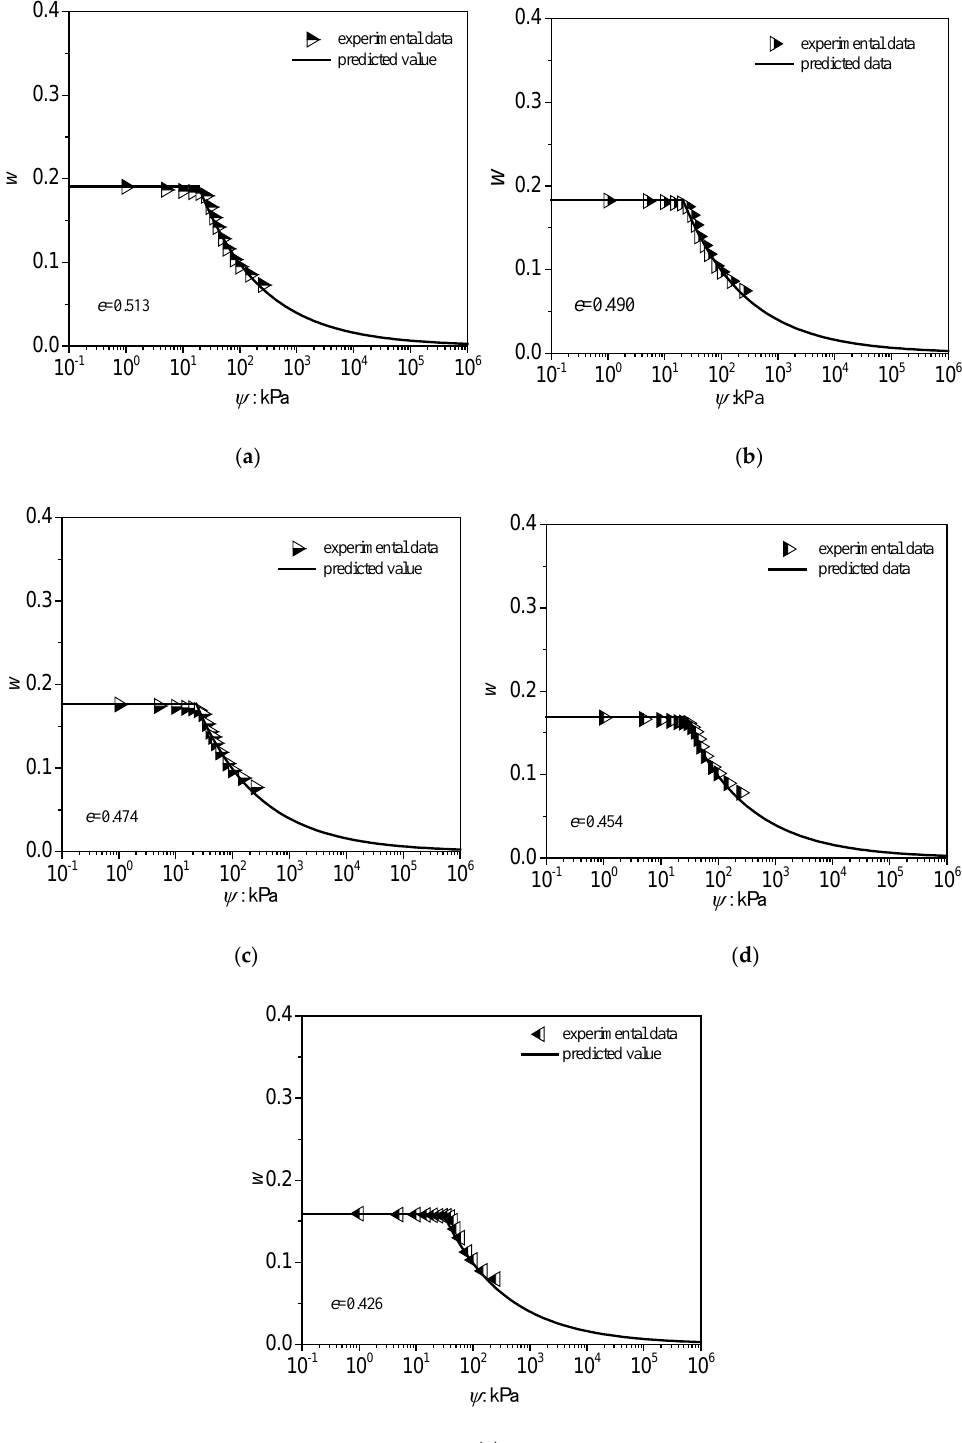
Figure 17. Measured and predicted SWCCs for Saskatchewan silt specimens (T2) at deformed state at ( a ) e = 0.513; ( b ) e = 0.490; ( c ) e = 0.474; ( d ) e = 0.454; ( e ) e = 0.426 (data after Huang [43]).